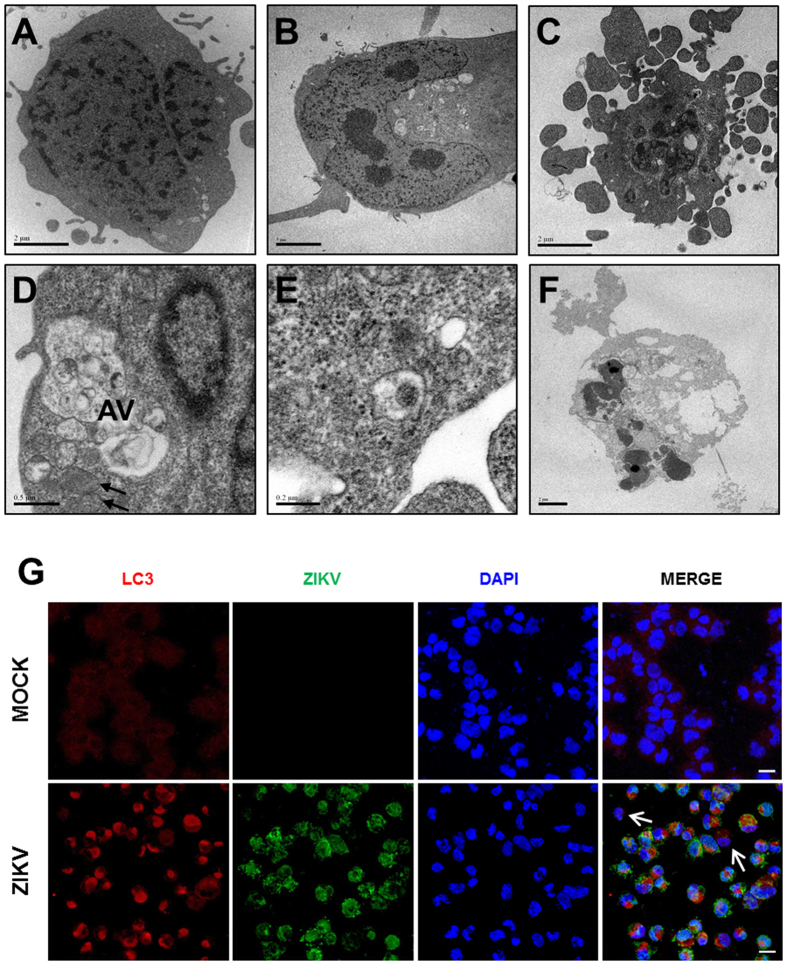
Ultrastructural analysis of NPC cultures after ZIKV infection.(A,B) Transmission electron micrographs of mock-infected cells, showing nuclei and organelles with normal aspect after 24 and 72 h of culture. (C–F) ZIKV-infected cells 24 (C,D), 48 (E) and 72 (F) h after infection. Cells in early (C) and late (F) apoptotic processes. (D) The presence of large perinuclear autophagic vacuoles (AV) can be observed. Black arrows indicate mitochondria with altered morphology. (E) Presence of viral capsid in intracellular vacuole. (G) Immunostaining for ZIKV (green) and the autophagic vacuole marker LC3 (red). Nuclei are stained with DAPI (blue). White arrows indicate cells with negative or low ZIKV staining, and absence of perinuclear LC3 staining. Scale bars = 20 μm.